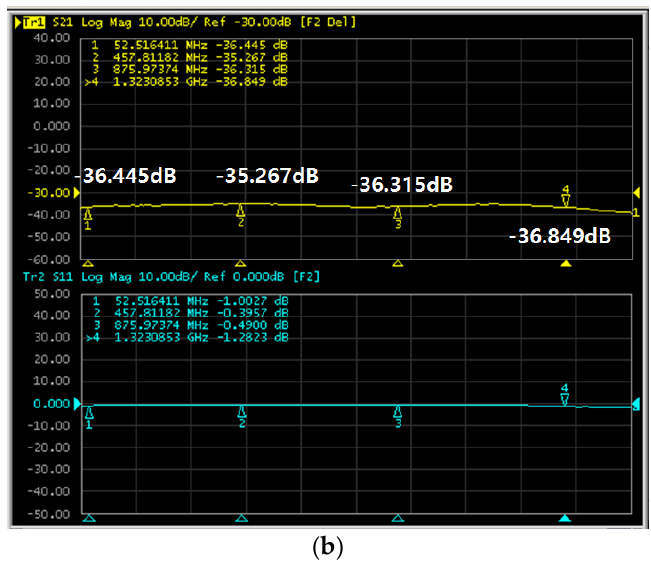
Figure 11. ( a ) 30 µ m metal-coated carbon fiber; ( b ) 40 µ m metal-coated carbon fiber.